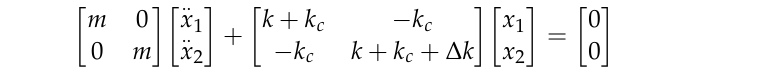
where x 1 and x 2 represent the displacement of each resonator, and ∆ k is the stiffness perturbation.